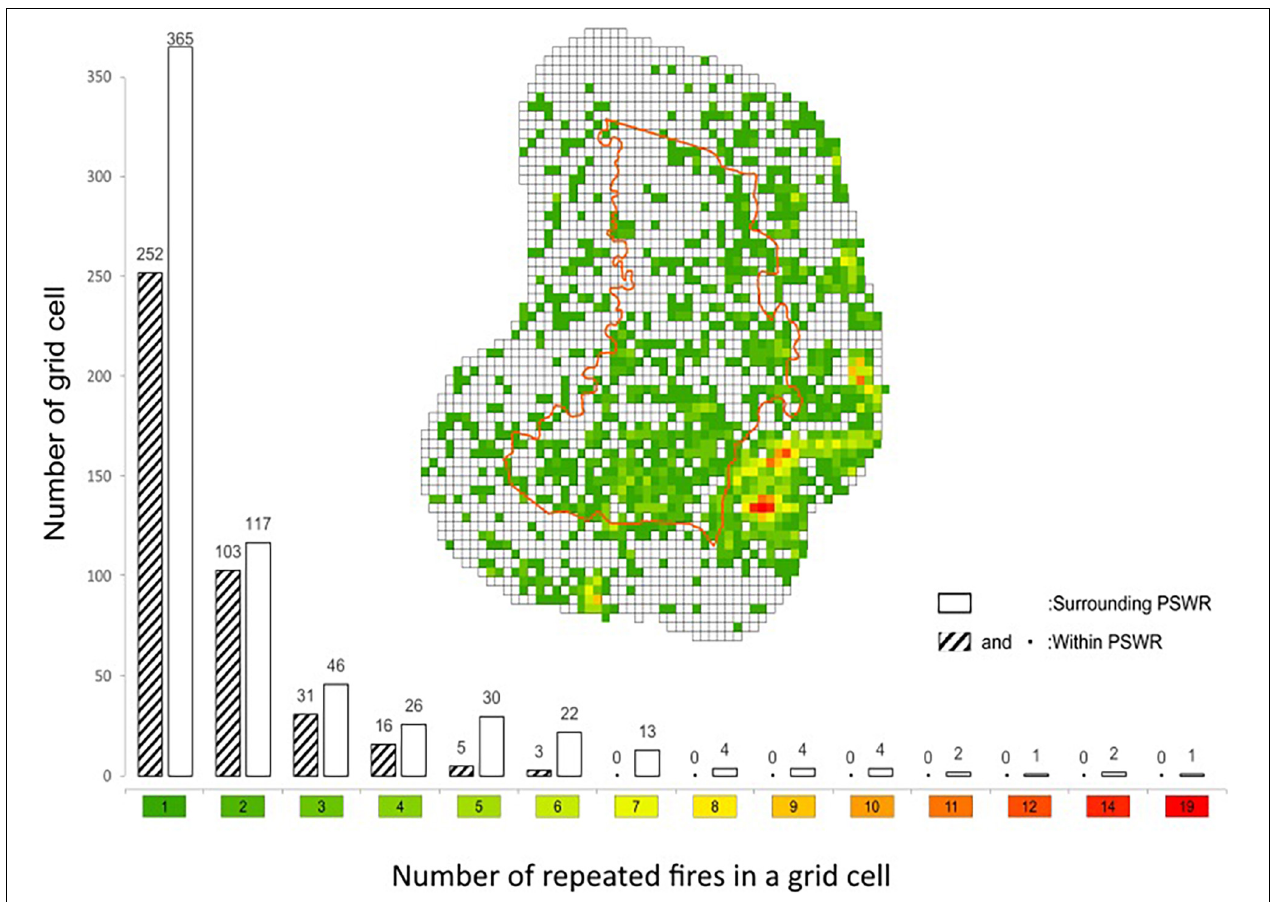
FIGURE 4 | Number of grid cells at each repeated fires grid cells within the Padang Sugihan Reserve and surrounding between 2001 and